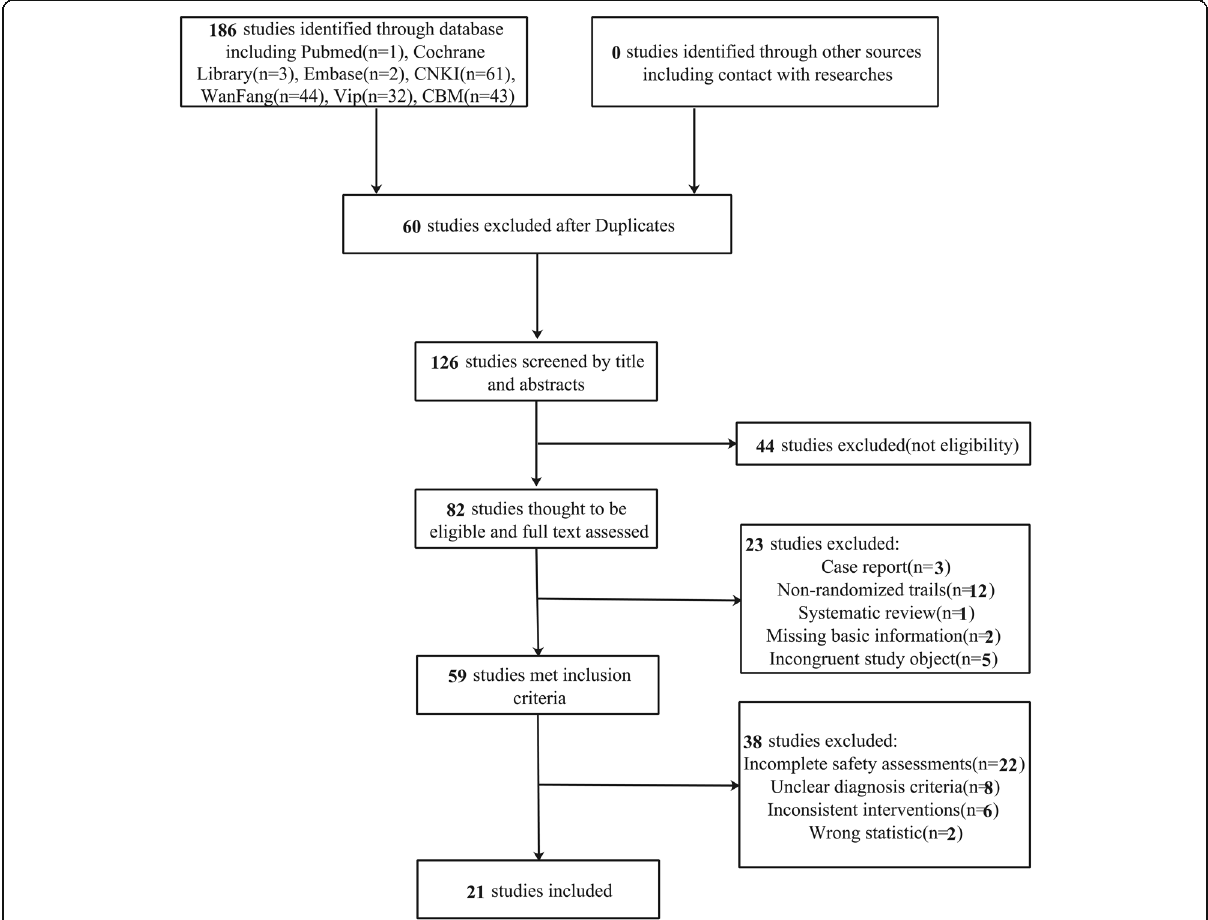
Fig. 1 Literature search and study selection